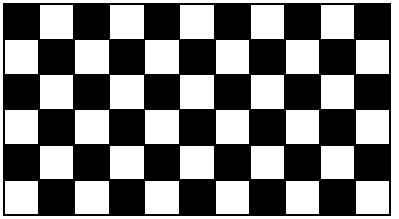
Figure 4. The worst case image pattern for raw memory